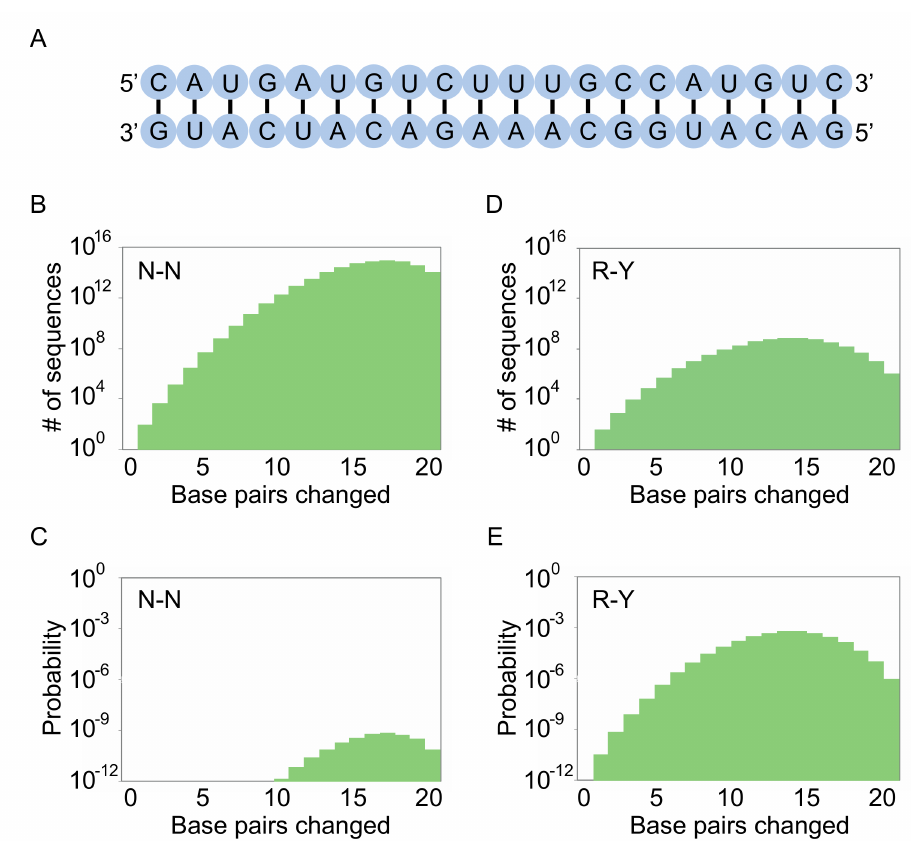
Figure 3. Encoding stems with degenerate positions. ( A ) A hypothetical stem made up of 20 base pairs. The sequence is arbitrary and does not affect the calculations in this panel. ( B ) Number of variants of this stem (including canonical A-U, U-A, C-G, and G-C base pairs as well as G.U and U.G wobble pairs) at various mutational distances from the starting sequence in a library in which base pairs are encoded by N-N. The total number of possible stem variants is 6 20 = 3.7 × 10 15 . ( C ) Probability distribution of sequences in a library based on this stem in which base pairs are encoded by N-N (N = A, C, G, or U; probability of forming a pair = 0.375). The y axis indicates the probability that a sequence in the library will have the potential to form each of the 20 base pairs in the stem. ( D ) Same as panel B, but for a library in which base pairs are encoded by R-Y (R = A or G; Y = C or U; probability of forming a pair = 0.75). Because only three of the six possible pairs can occur with this coding scheme, the number of possible stem variants is 3 20 = 3.5 × 10 9 . ( E ) Same as panel C, but for a library in which base pairs are encoded by